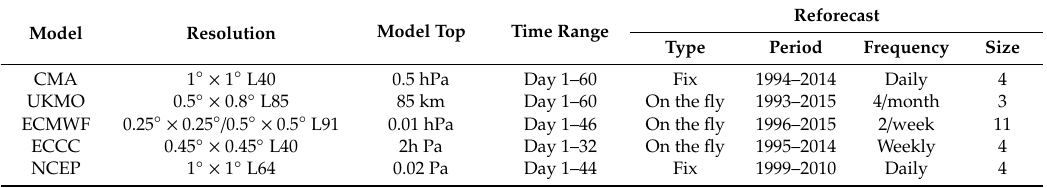
Table 1. Information on the five Sub-seasonal to seasonal models used in this study.